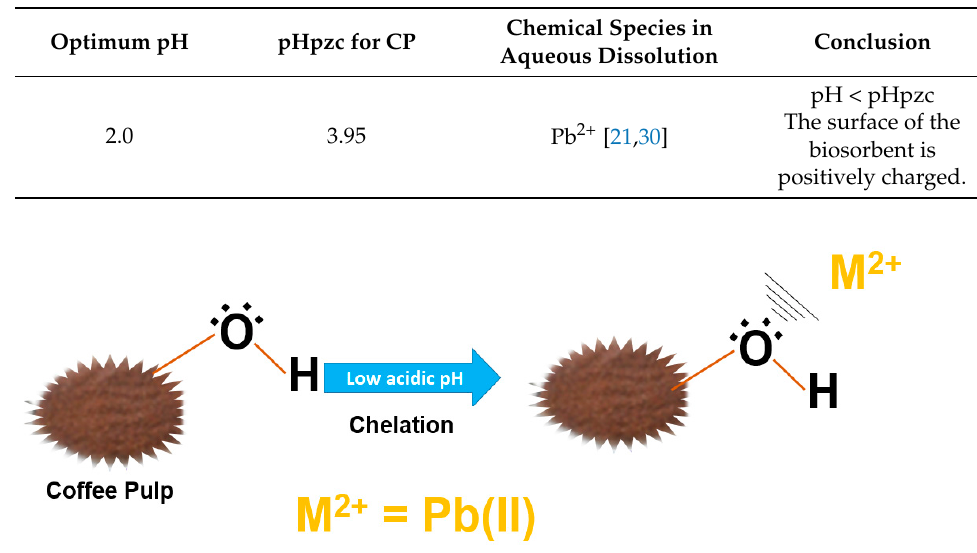
Figure 5. Adsorption mechanism of Pb(II) sorption with CP proposed by the authors based on Sutirman [54].